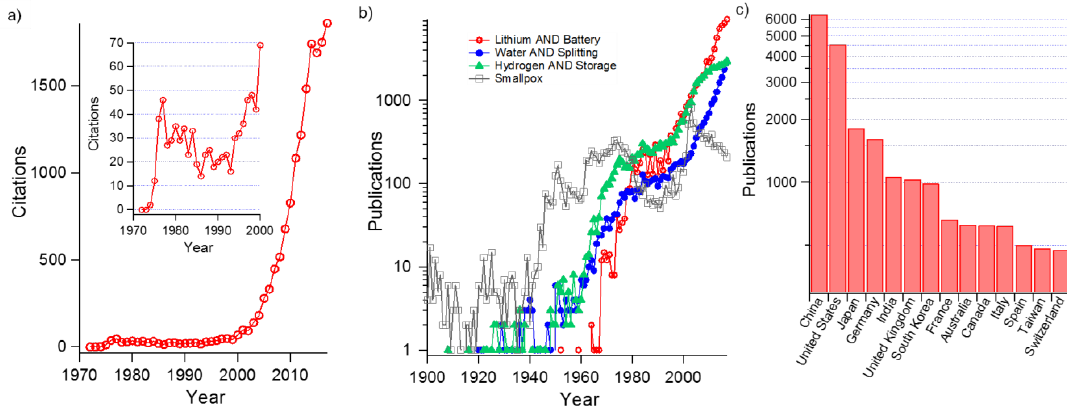
Figure 3. ( a ) Number of citations of the Fujishima and Honda 1972 article as a function of the time; inset: magnification of the 1970–2000 period. ( b ) Number of research article as a function of the publication year for lithium batteries, water splitting and hydrogen storage; smallpox is reported for comparison purposes. ( c ) Geographical distribution of the publications related to water splitting from 1920 to present. All the data were collected using the database Scopus ® , Elsevier.